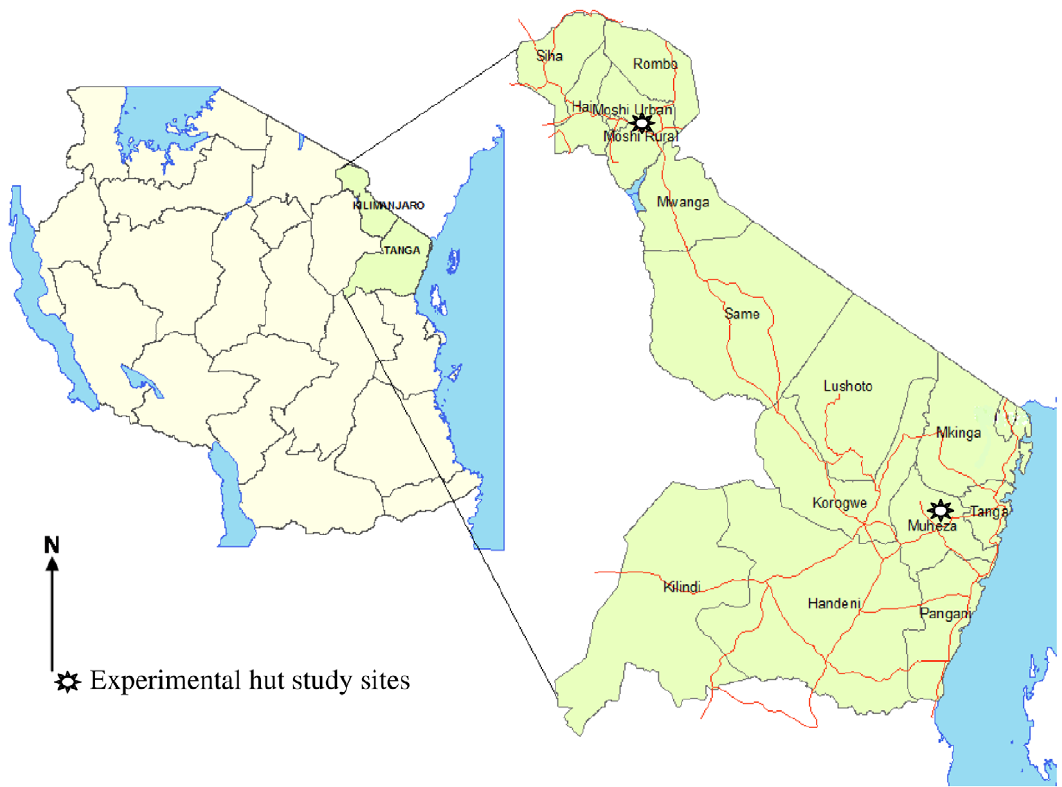
Figure 1. Map showing the location of the field stations, in Moshi and Muheza, north-eastern Tanzania.